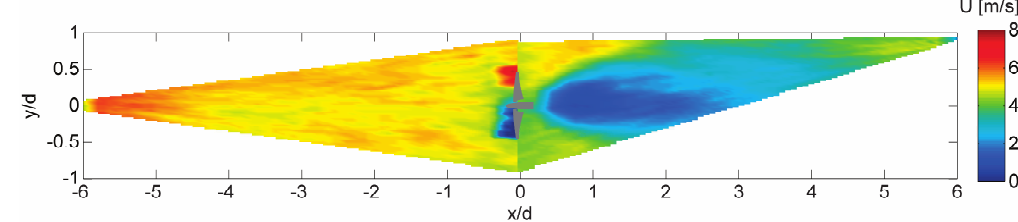
Figure 3. Velocity field measured through simultaneous PPI scans.